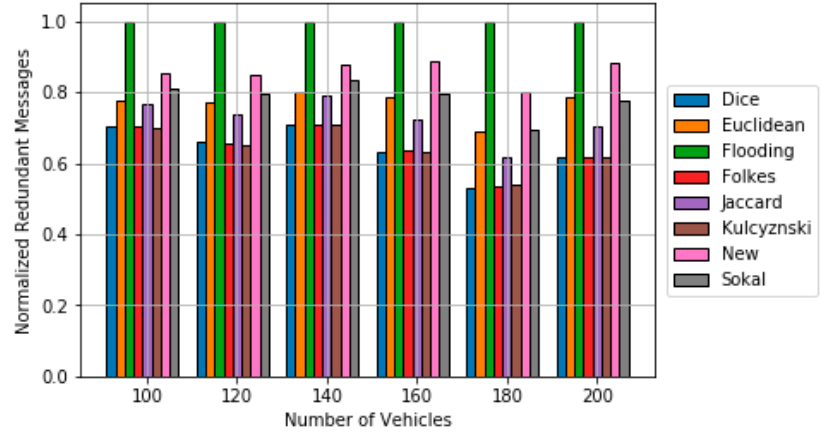
Figure 9. Comparison of redundancy results for the polynomial scheme based on the different dissimilarity.